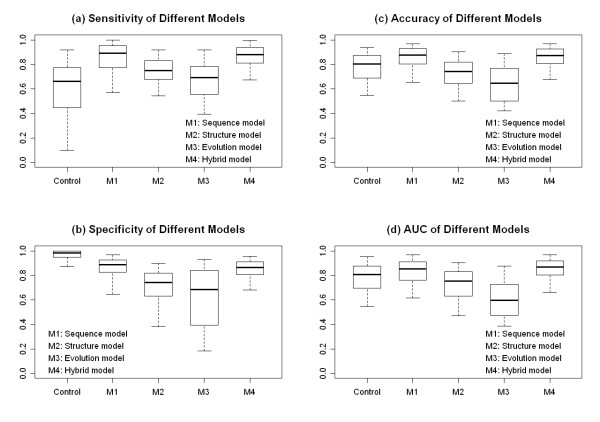
Performance comparison of different models for 309 TF-TFBSs (with PWM information). Panel(a)-(d): boxplots of 5 models (the control model, the sequence model, the structure model, the evolution model, and the hybrid model) for sensitivity, specificity, accuracy and AUC measurement. For a boxplot, the 5 whiskers from bottom to top denote the 5th, 25th, 50th, 75th, and 95th percentile respectively.